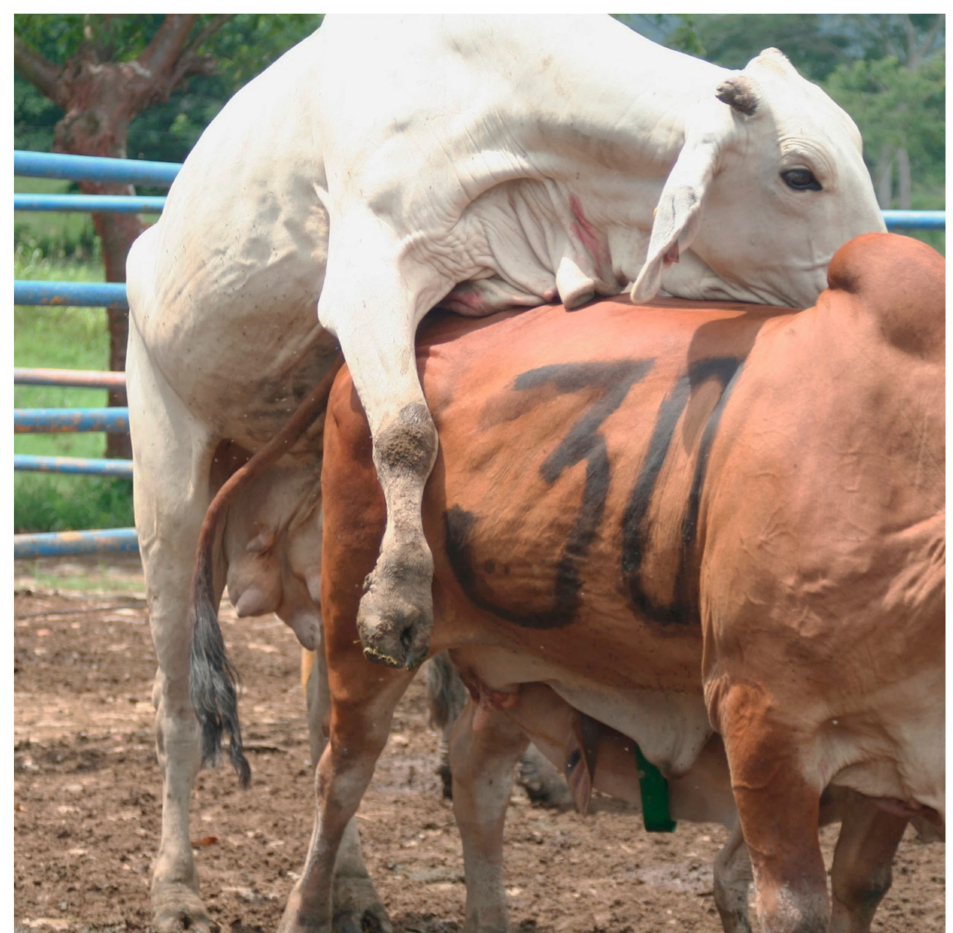
Figure 2. Two lactating cows display sexual behavior. The cow in the bottom shows sexual receptivity even while nursing. Reproductive activity in Zebu cows can be induced after a period of separation between the mother and her calf, inhibiting the negative effect of suckling and the presence of the offspring on the resumption of postpartum ovarian